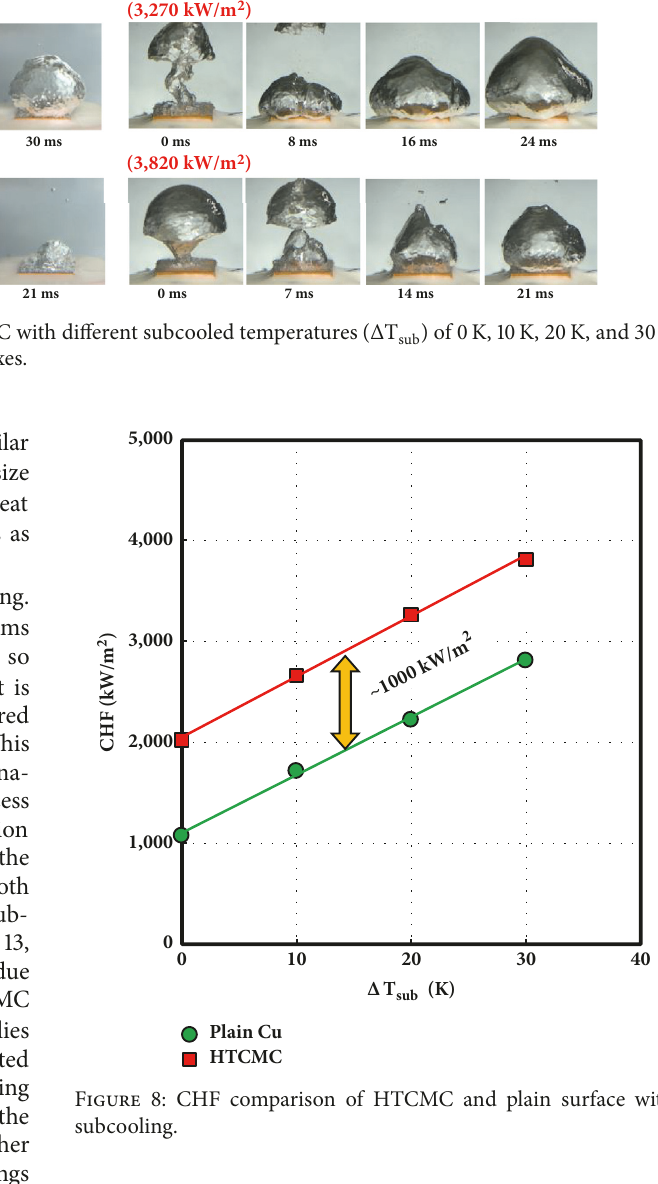
Figure 8: CHF comparison of HTCMC and plain surface with